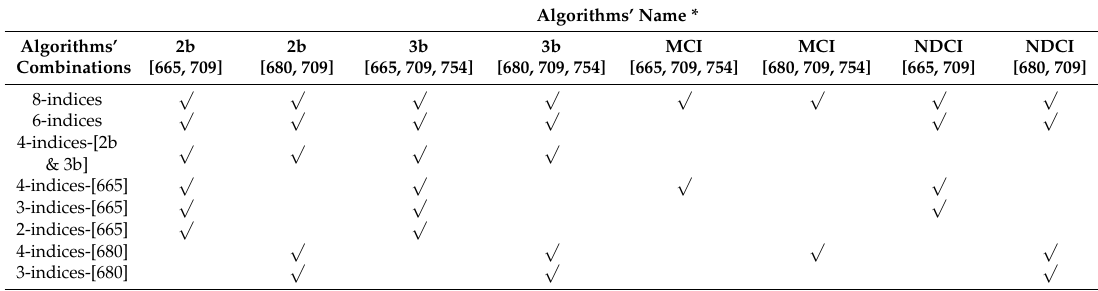
Table 4. Algorithms’ combination investigated with multi-algorithm indices and the look-up table (MAIN-LUT) technique.